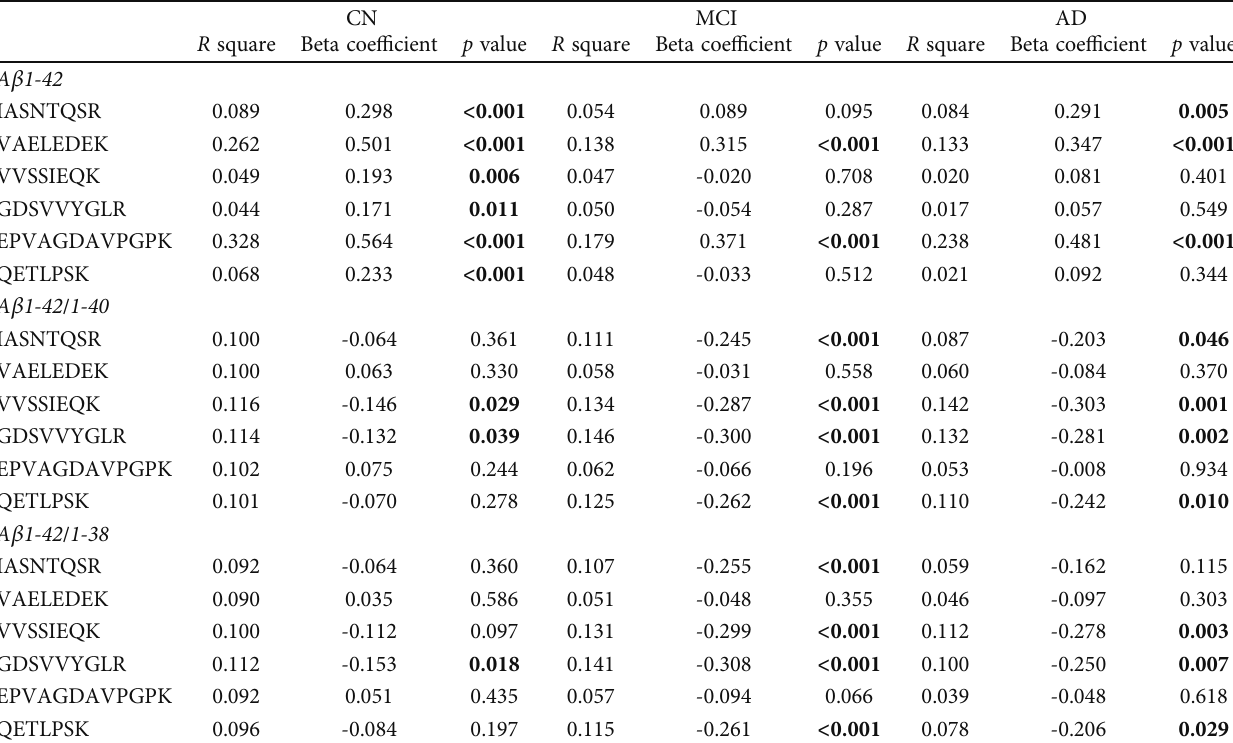
Table 3: Linear regression between amyloid- β ratios and targeted proteomics. CN